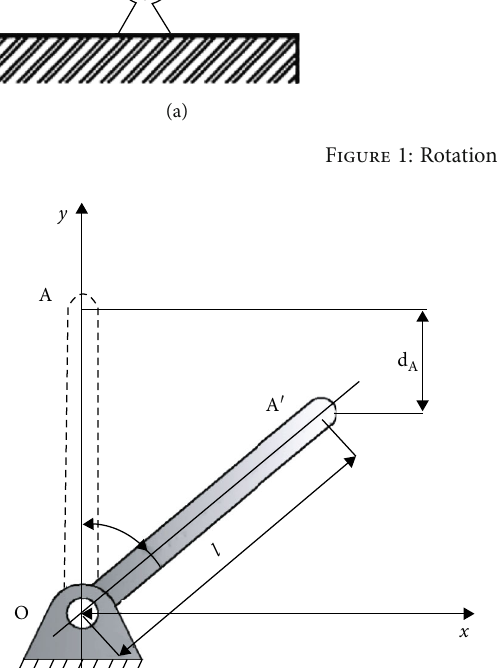
Figure 1: Rotation center and virtual rotation center.